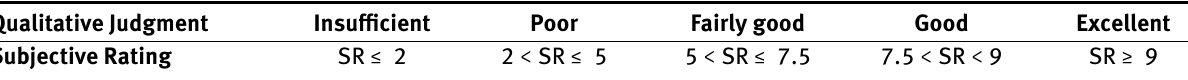
Table 4: Proposed Subjective Rating classification